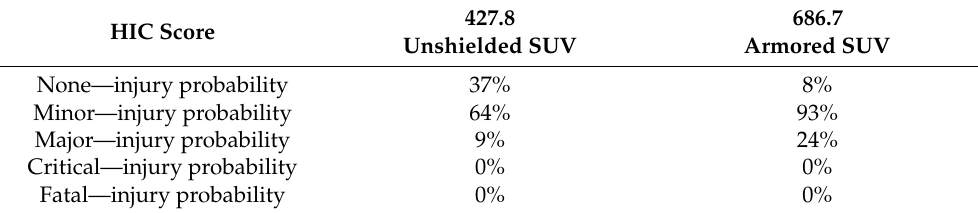
Table 6. Head Injury Severity probabilities.